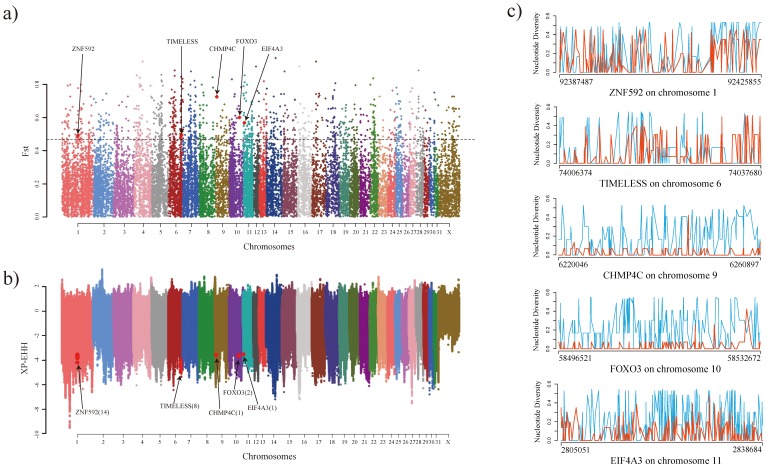
Signatures of correlation between DEGs from Thoroughbred RNA-seq and selected genes associated with nucleotide diversity, FST and XP-EHH from Thoroughbred and Jeju pony DNA sequence.a) Manhattan plot of FST (Dotted line = cut-off value of the top 5% with empirical p-values of <0.05. Red point = common genes between the DEGs, Thoroughbred selected genes associated with FST and XP-EHH). b) Manhattan plot of XP-EHH value (Red point = Common genes between the DEGs and Thoroughbred selected genes associated with FST and XP-EHH). c) Nucleotide diversity line plot of five common genes (sky blue color line = Jeju pony, orange color line = Thoroughbred).